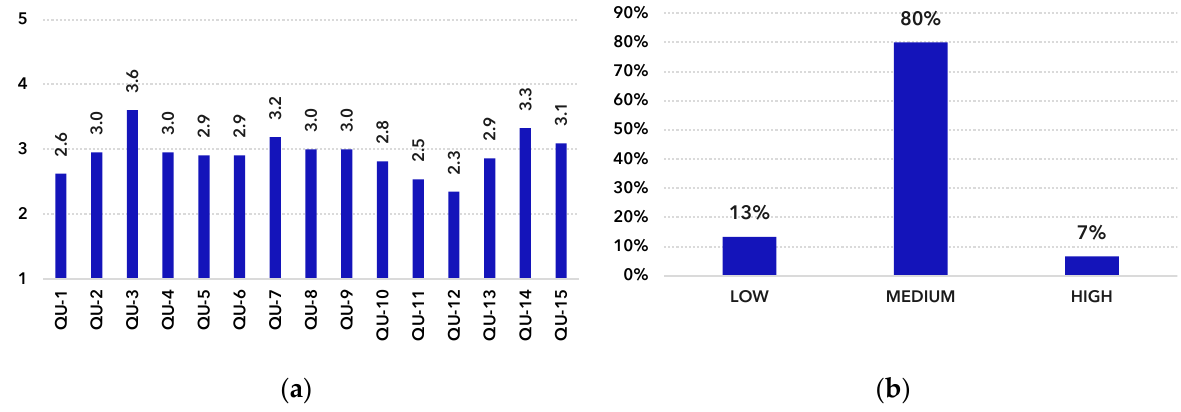
Figure 7. ( a ) Characteristic vulnerability index graph; ( b ) Percentage distribution of the characteristic vulnerability index values.